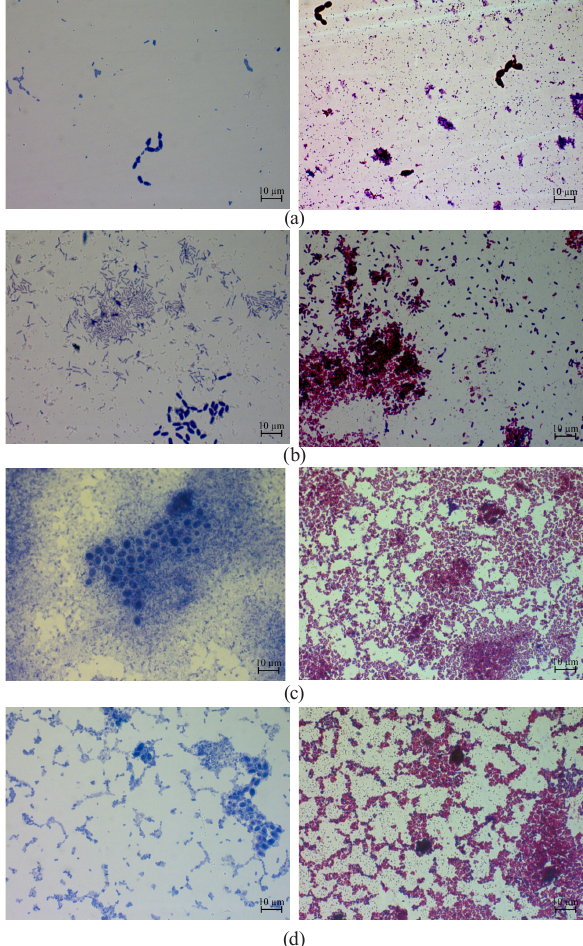
Figure 4 Micrographs of biofilms formed in acid whey permeate in: (a) 8 h, (b) 24 h, (c) 48 h, and (d) 72 h. Methylene blue staining (left) and Gram-staining (right). Magnification